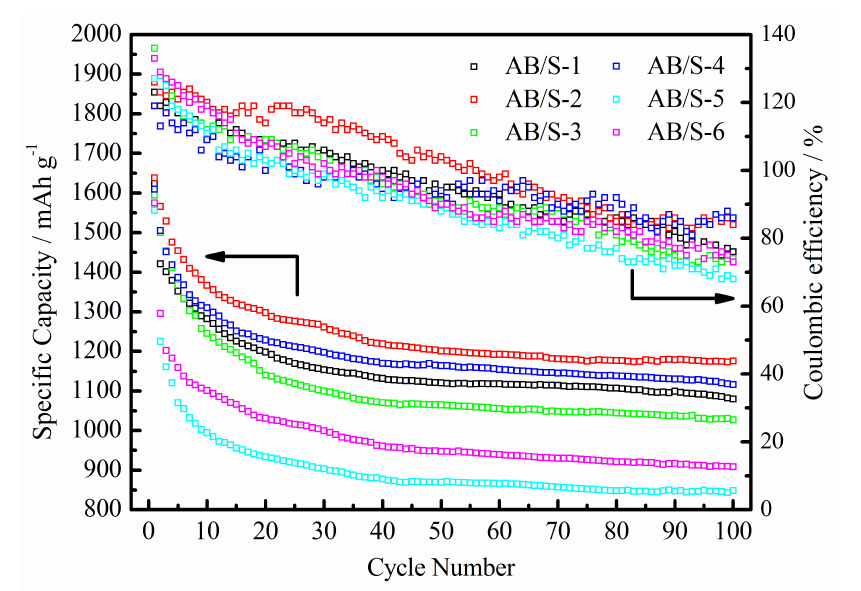
Figure 2. Cycle performance and coulombic efficiency curves of the composite